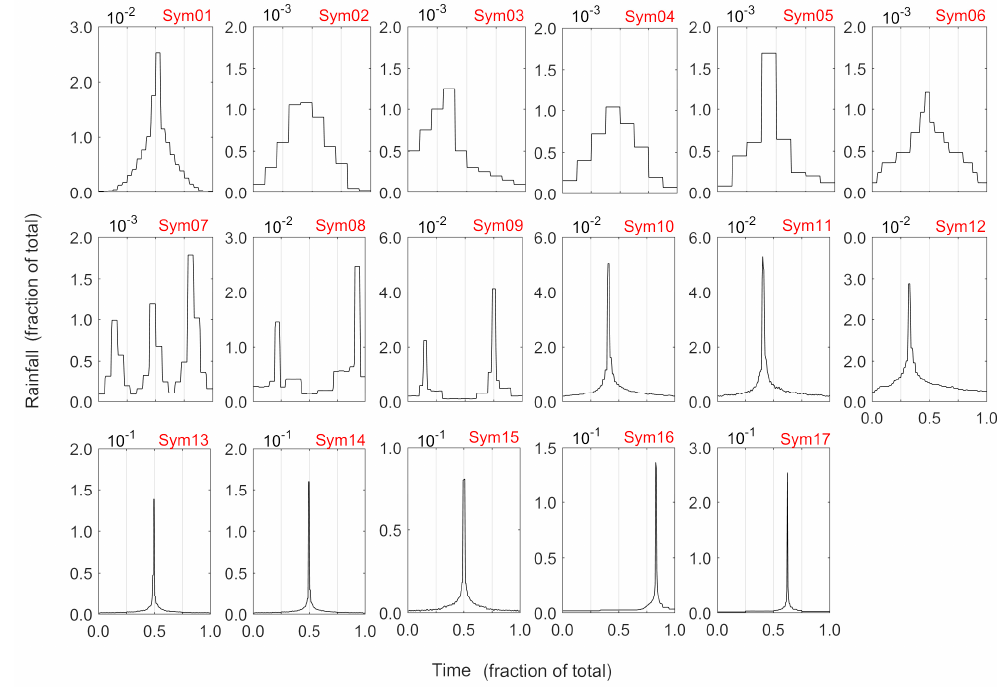
Figure 2. Hyetographs simulated for the calculation of the updated Network Saturation Index (uNSI). Hyetographs include: a dimensionless rainfall (Sym01) [47], hyetographs for rainfalls of 1, 2, 4, 8, 24, 48, 72, 168, 240 h (Sym02 to Sym09 respectively) [48], the SCS/NRCS hydrographs (type I (for a design storm of 24 and 48 h), type Ia (for 24 h), type II (for a design storm of 24 and 48 h) and type III (for 24 h)) (Sym10 to Sym15 respectively) [49], and two more hyetographs proposed for a rainfall of 72 and 96 h (Sym16 and Sym17) [50].